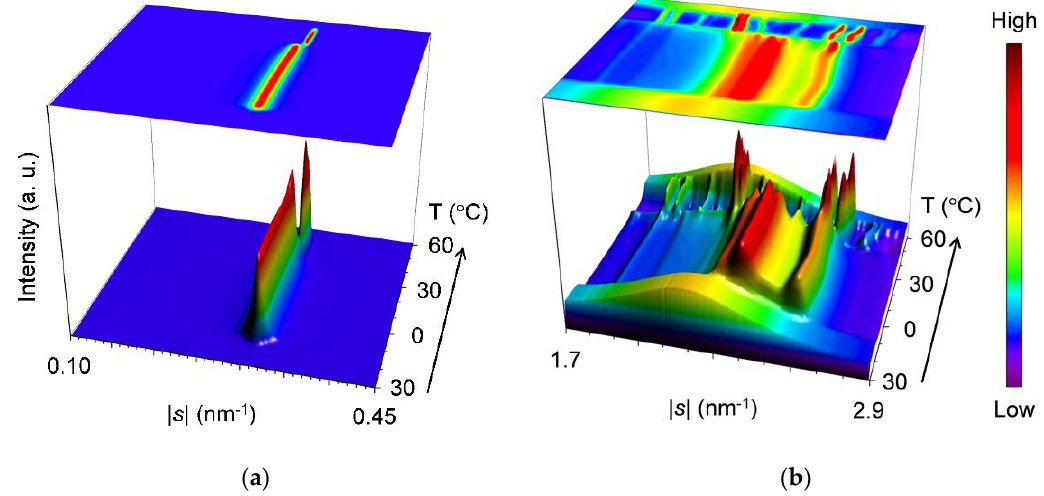
Figure 2. Topographic plots of the synchrotron X-ray diffractometry (SR-XRD) data for SOS/LLL ( w LLL = 0.950), taken during the cooling at a rate of 2 °C/min and subsequent heating at a rate of 5 °C/min: ( a ) small-angle X-ray scattering (SAXS); and ( b ) wide-angle X-ray scattering (WAXS).